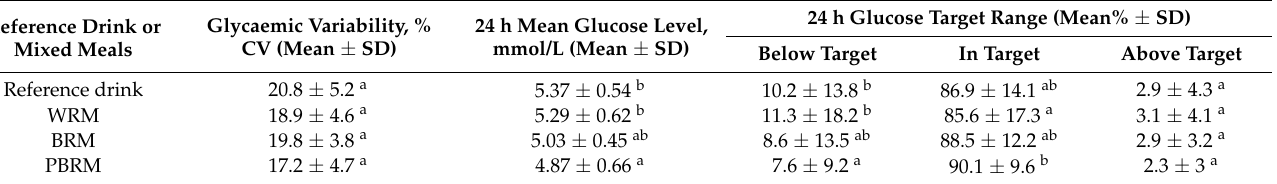
Table 4. The 24 h mean glucose level, 24 h glucose target ranges and glycaemic variability of reference drink and mixed